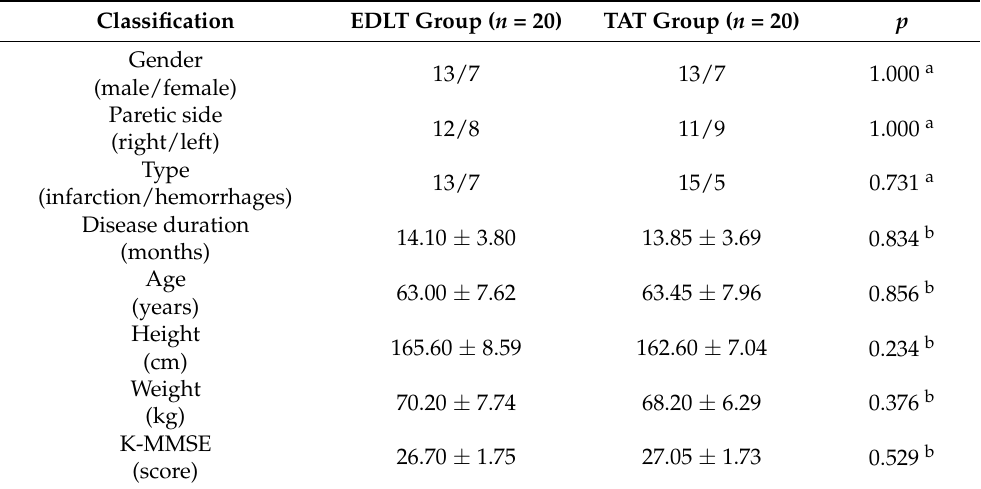
Table 1. General characteristics.